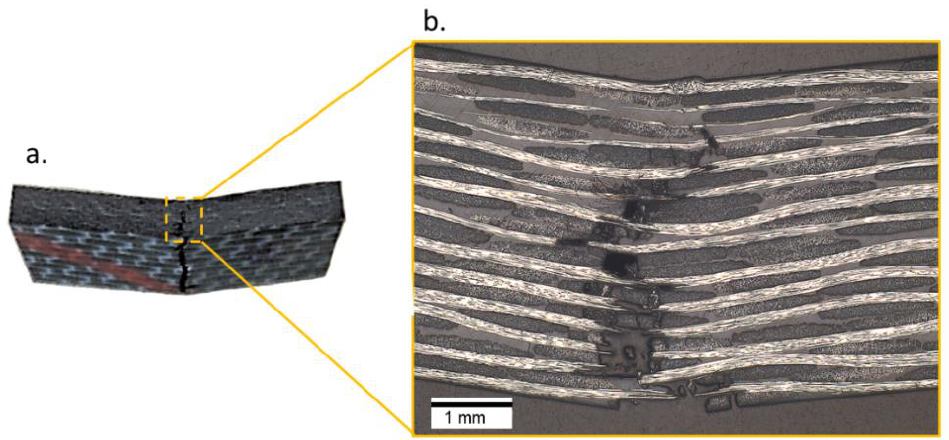
Figure 6. ( a ) Monotonic failure due to high tensile strain in the bottom layers of the specimen and ( b ) a closer look at the crack propagation location captured by the light optical digital microscope.